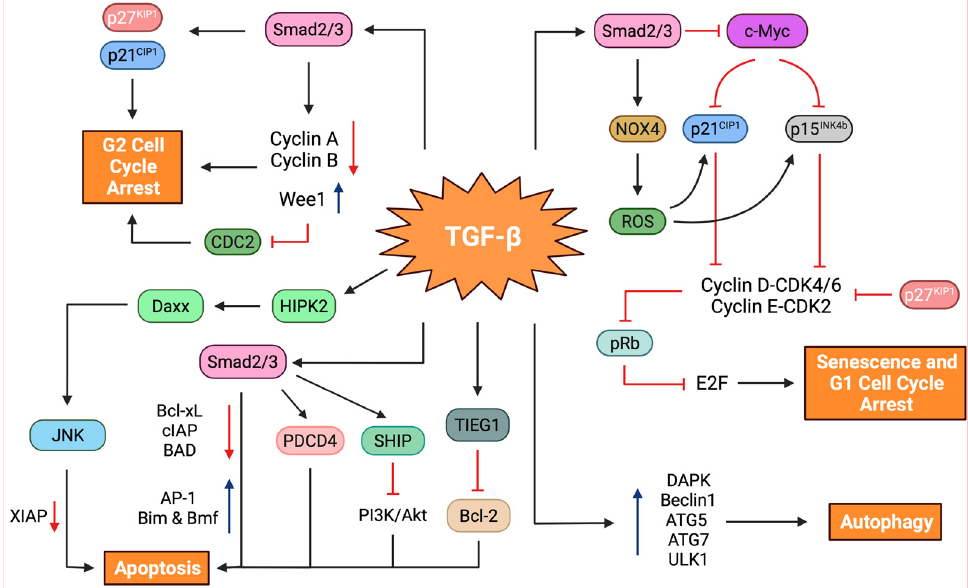
Figure 3. Tumor suppressor functions of TGF- β signaling. TGF- β inhibits cell proliferation and induces cellular senescence by increasing the expression of the CDK inhibitors p21 CIP1 and p15 INK4b , with a reciprocal decrease in hypophosphorylated pRb and c-Myc levels. This process generally requires NOX4-mediated ROS production. TGF- β can also induce G2 cell cycle arrest by upregulating p21 CIP1 and p27 KIP1 , accompanied by a decrease in cyclin A and cyclin B levels and an increased activity of Wee1 kinase. In addition, TGF- β stimulates apoptosis by modulating several effector molecules and signaling circuits, including Bcl-xL, Bim, Bmf, cIAP, XIAP, AP-1, and PDCD4, and the PI3K/Akt cascade. TGF- β -induced autophagy involves the activation of several autophagy-related molecules, such as DAPK, Beclin1, ATG5, ATG7, and ULK1. TGF- β can also induce G2 arrest in HCC cell lines. The study by Hashimoto et